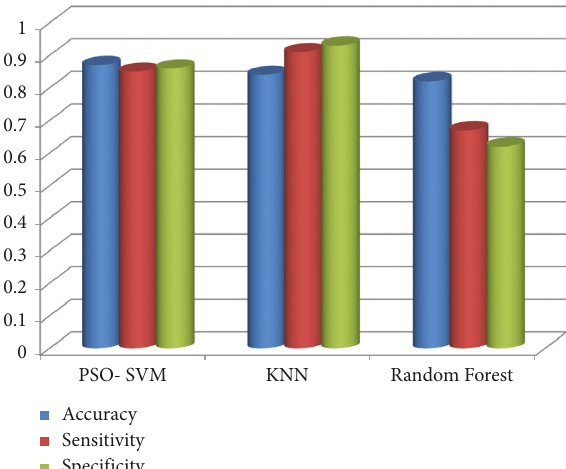
Figure 2: Classifiers’ performance without feature selection and feature extraction.